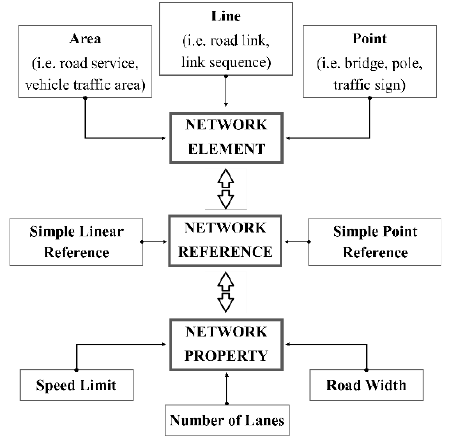
Figure 3. Simplified entity-relationship diagram.